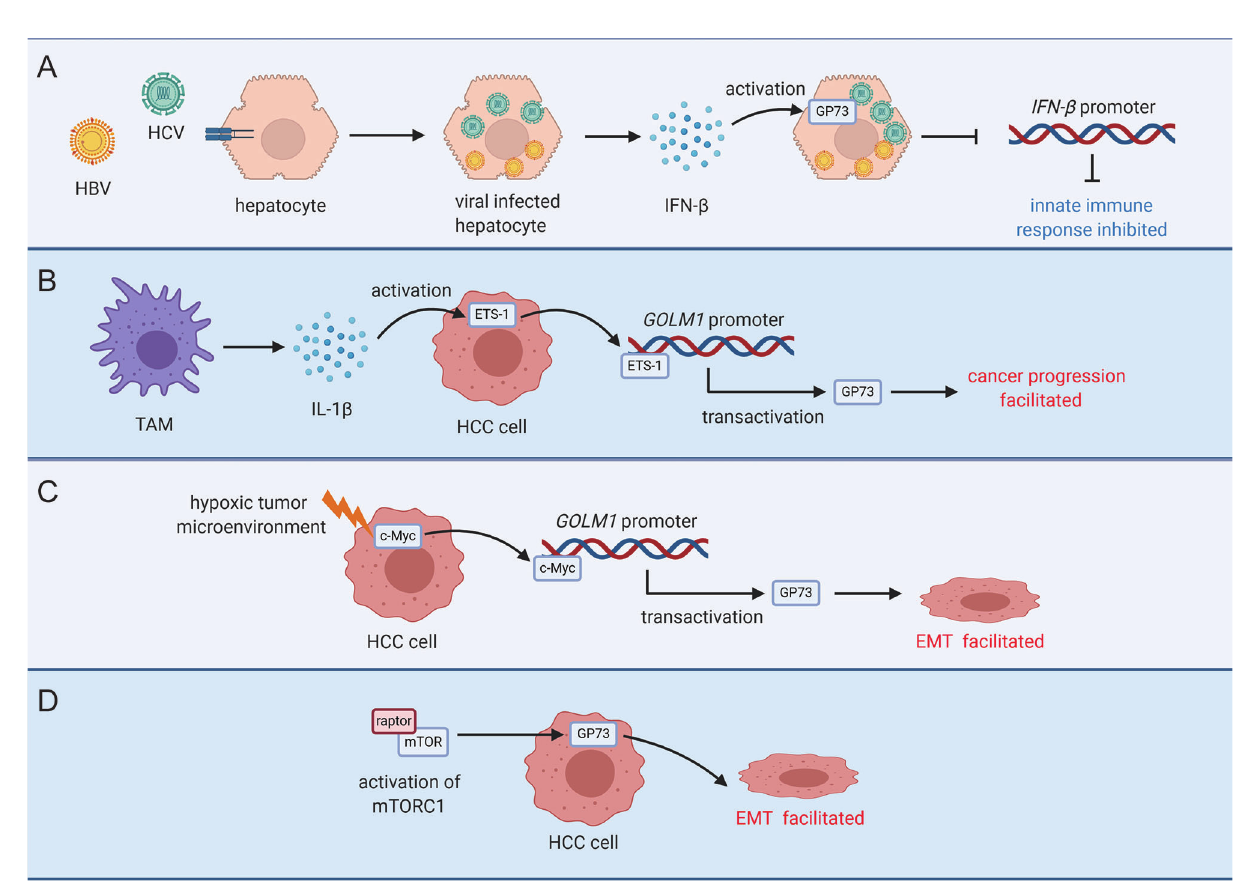
FIGURE 2 | Activation modes of GP73 in viral infected cells or cancer cells. (A) INF- b secreted by viral-infected hepatocytes activates GP73 in target cells and inhibits innate immune response. (B) TAM-secreted IL-1 b upregulates ETS-1 in cancer cells and ETS-1 transactivates GP73 to facilitate cancer progression. (C) Upregulation of c-Myc in a mildly hypoxic tumor microenvironment transactivates GP73 and facilitates EMT of cancer cells. (D) GP73 is upregulated by mTORC1, and EMT of cancer cells is